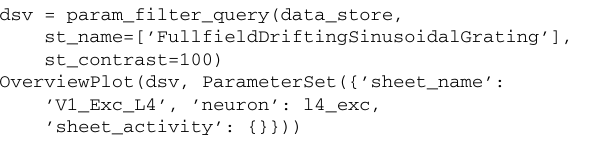
for the five times each stimulus was presented. The middle panel shows the excitatory (red) and inhibitory (blue) conductances recorded during the stimulus presentation; the pale lines show single trial traces while the thick saturated lines show the trial average trace. The bottom panels show the membrane potential traces recorded during the stimulus presentation; the gray lines showing the single trial traces while the black line shows the trial averaged